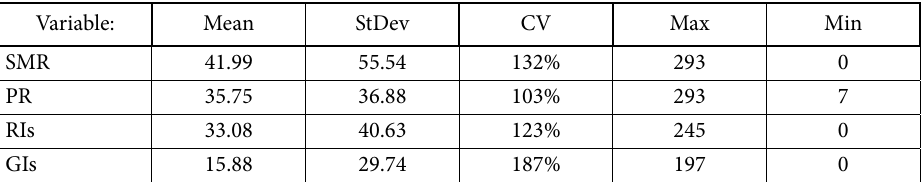
Figure 3. Trade interventions that affect Poland between January 2009 and December 2020 (source: authors’ own elaboration based on Global Trade Data, Table 3. Basic descriptive statistics of variables (source: own elaboration, 2022)